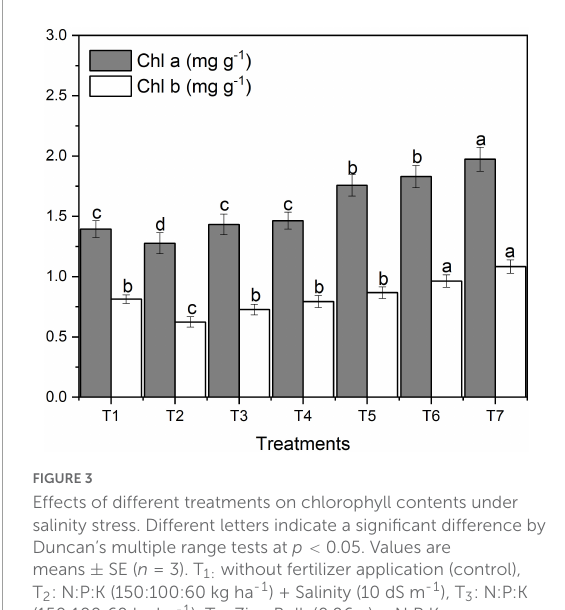
FIGURE4 Effects of different treatments on grain yield per plant and 1,000 grain weight under salinity stress. Different letters indicate a significant difference by Duncan’s multiple range tests at p < 0.05. Values are means ± SE ( n = 3). T 1 : without fertilizer application (control), T 2 : N:P:K (150:100:60 kg ha - 1 ) + Salinity (10 dS m - 1 ), T 3 : N:P:K (150:100:60 kg ha - 1 ), T 4 : Zinc